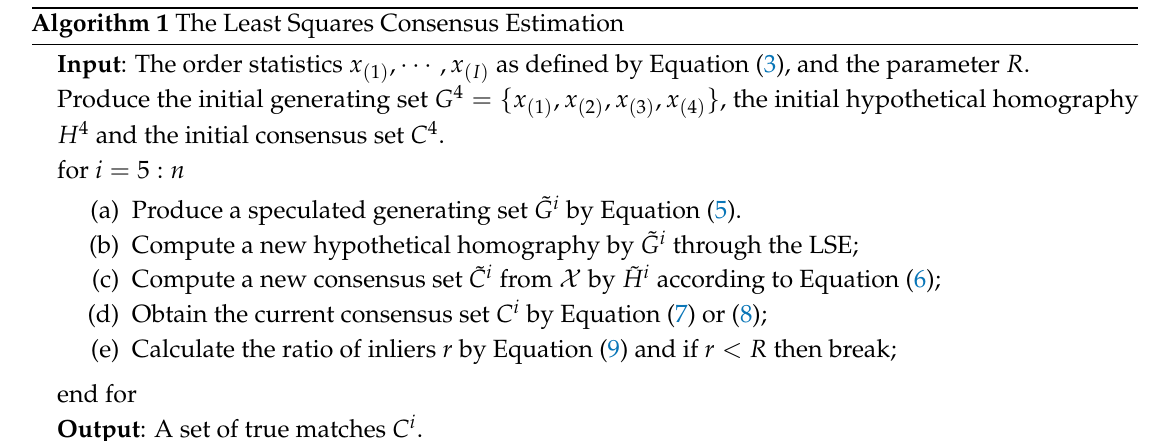
Table 1. Main Parameters in RANSAC and MSAC.